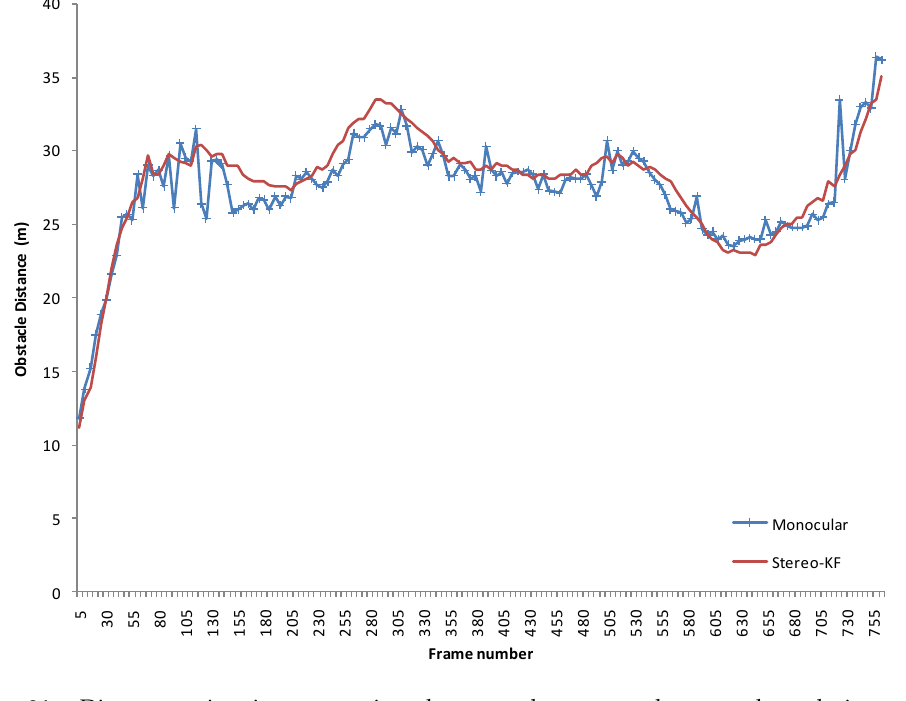
Figure 21. Distance estimation comparison between the proposed monocular solution and a stereovision-based solution. Table 4. Detection rate comparison between the monocular approach and stereovision.